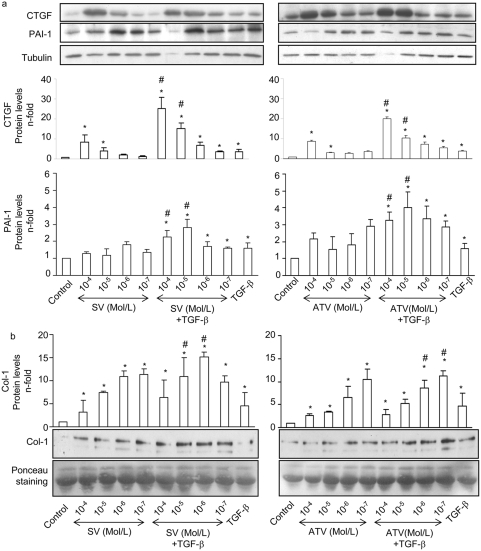
Statins enhance TGF-β dependent ECM regulatory proteins upregulation In VSMCs.a. Serum starved VSMCs were preincubated for 48h with several concentrations (10−4 to 10−7 mol/L) of Simvastatin (SV) or Atorvastatin (ATV), and then stimulated with 1 ng/mL TGF-β for 24h. These cells were compared with those treated with TGF-β in the absence of statin pretreatment. Figure a shows in the upper panel representative western blot and in the lower panel relative CTGF and PAI-1 protein levels expressed as mean±SEM of 4 experiments. *p<0.05 vs. control. # p<0.05 vs. TGF-β. b. Statins increase Col-1 secretion induced by TGF-β. Serum starved VSMCs were preincubated for 24h with several concentrations (10−5 to 10−7 mol/L) of Simvastatin (SV) or Atorvastatin (ATV), and then stimulated with 1 ng/mL TGF-β for additional 72h. Conditioned media were analyzed for its Col-1 content by western blot. Figure shows in the lower panel a representative western blot and in the upper panel media the mean±SEM of 4 experiments. *p<0.05 vs. control. # p<0.05 vs. TGF-β.